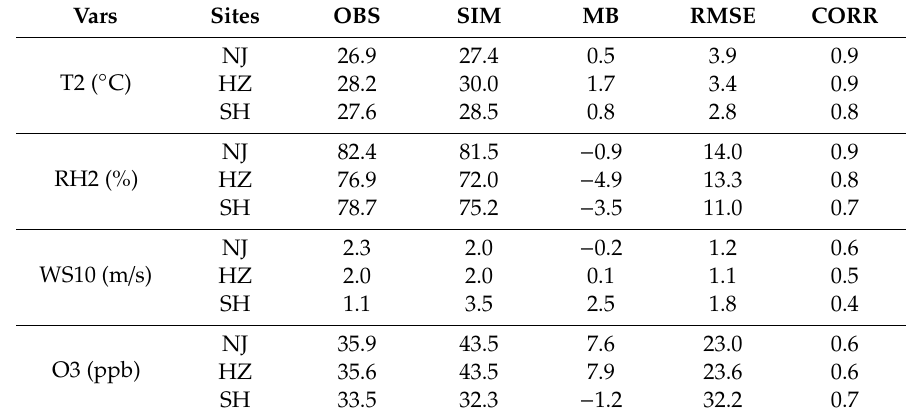
Table 2. The statistics of meteorological conditions and ozone concentrations from PREMET at three sites. Vars Sites